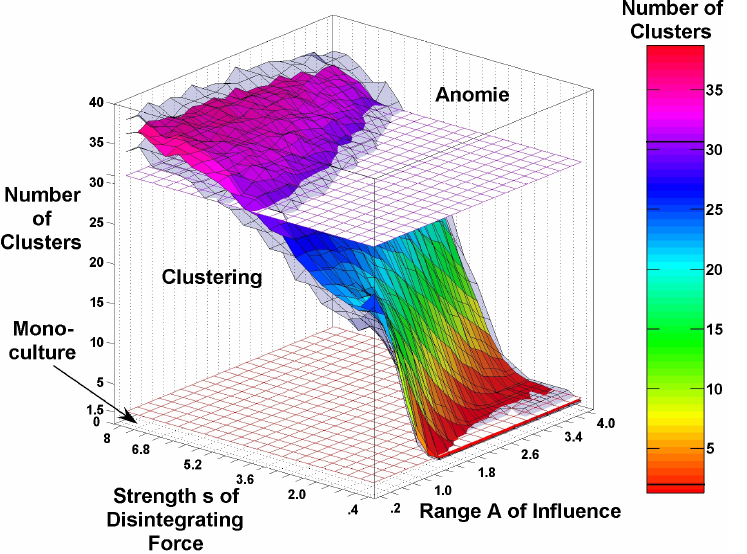
Figure 3. Conditions of clustering, monoculture and Anomie. The figure shows the dependence of the average number of clusters in the Durkheimian model on the strength s of the disintegrating force and the range A of social influence. To generate it, we conducted computer simulations with N ~ 100 agents, starting with initial consensus ( o i (0) ~ 0 for all i ). We restricted opinions to values between 2 250 and 250. We varied the strength s of the disintegrating force between s ~ 0 : 4 and s ~ 8 in steps of 0.4. A varied between A ~ 0 : 2 and A ~ 4 in steps of 0.2. For each parameter combination, we conducted 100 independent replications and assessed the average number of clusters formed after 250,000 iterations (see z -axis and the color scale). The two transparent (gray) surfaces depict the inter-quartile range, which indicates a small variance in the number of clusters (and also typical cluster sizes) for each parameter combination. The horizontal grids indicate the borders of the three phases, as defined by us. An average cluster size below 1.5 indicates monoculture. Values between 1.5 and 31 reflect clustering. Finally, values above 31 correspond to opinion distributions that cannot be distinguished from random ones and represent a state of anomie.